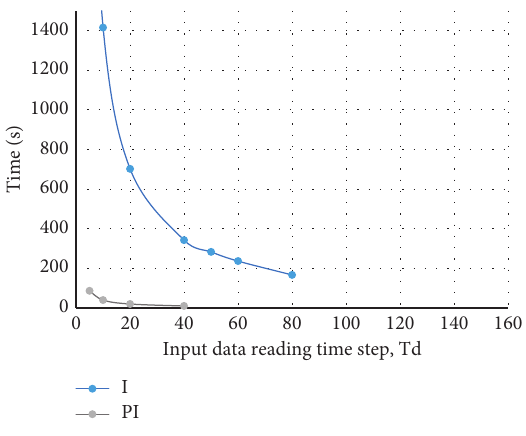
Figure 11: Duration of oscillation. Table 2: Oscillation duration.